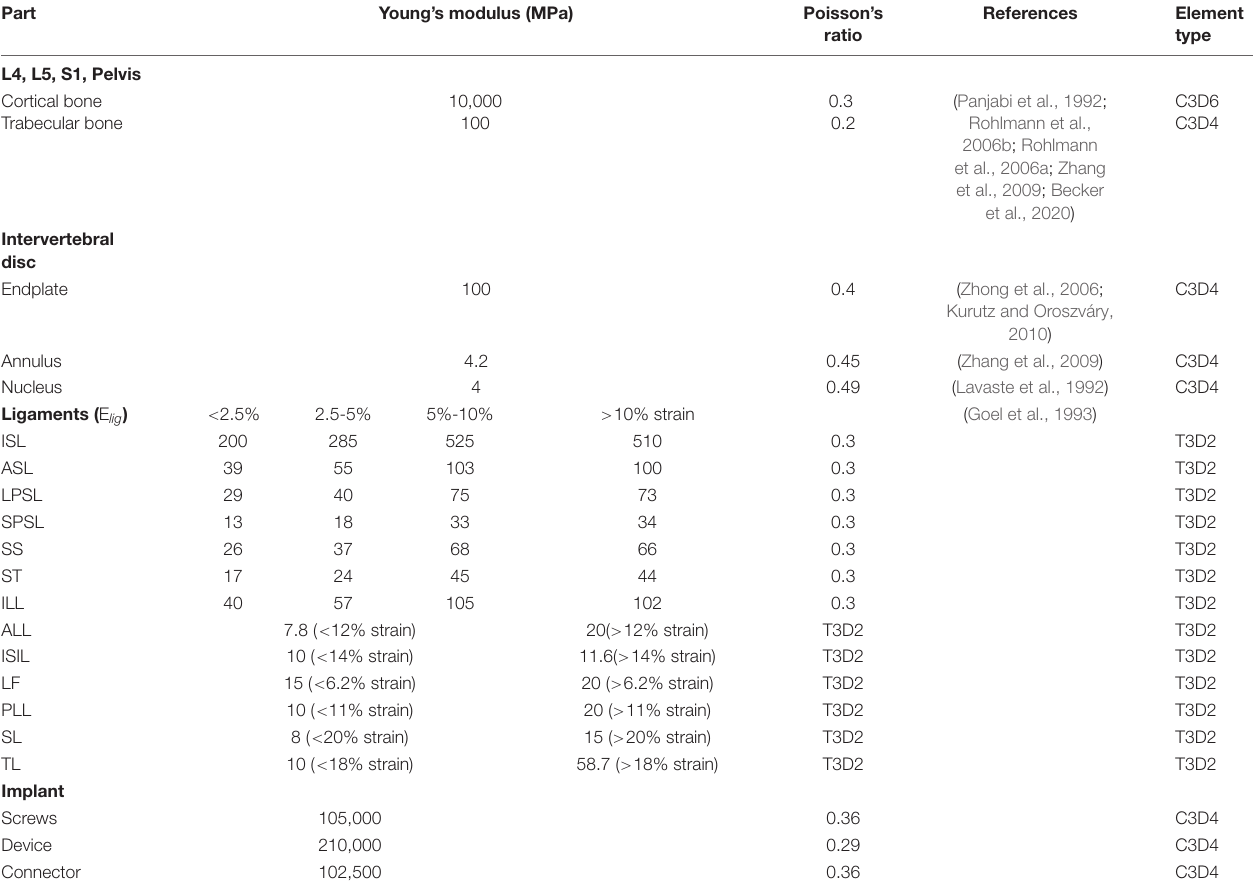
TABLE 1 | Material parameter values employed in numerical simulations.